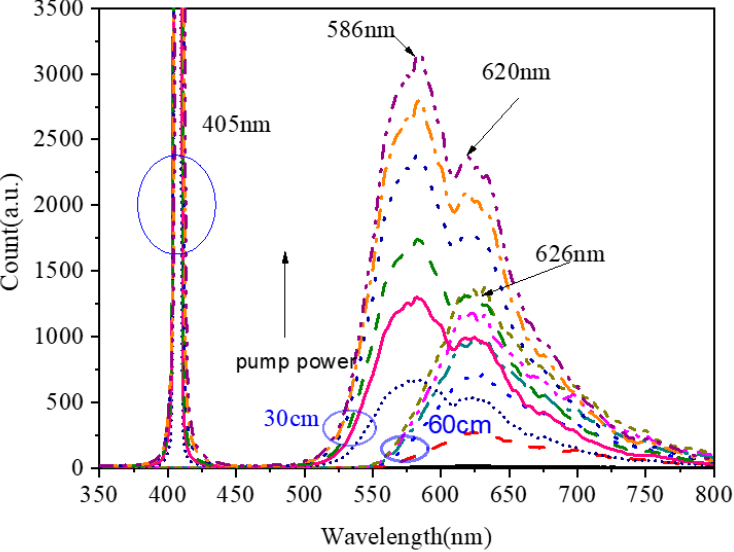
Figure 9. Emission spectra of Yb 2+ -doped fiber lengths of 30 and 60 cm as a function of pump power at the excitation of 405